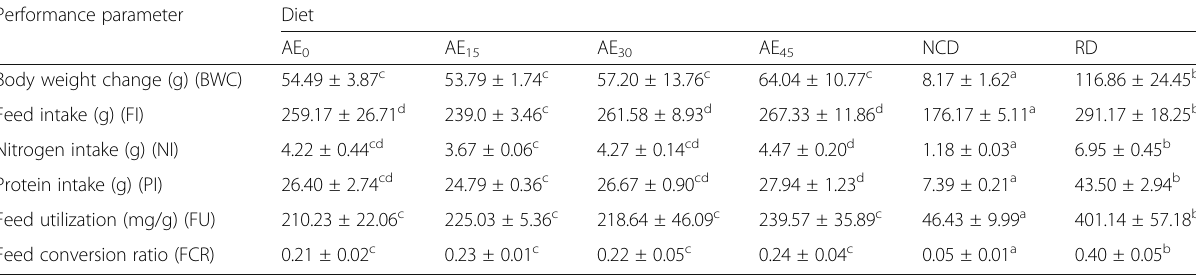
Table 3 Growth performance of rats fed diets based on raw and macerated African elemi pulp flours Performance